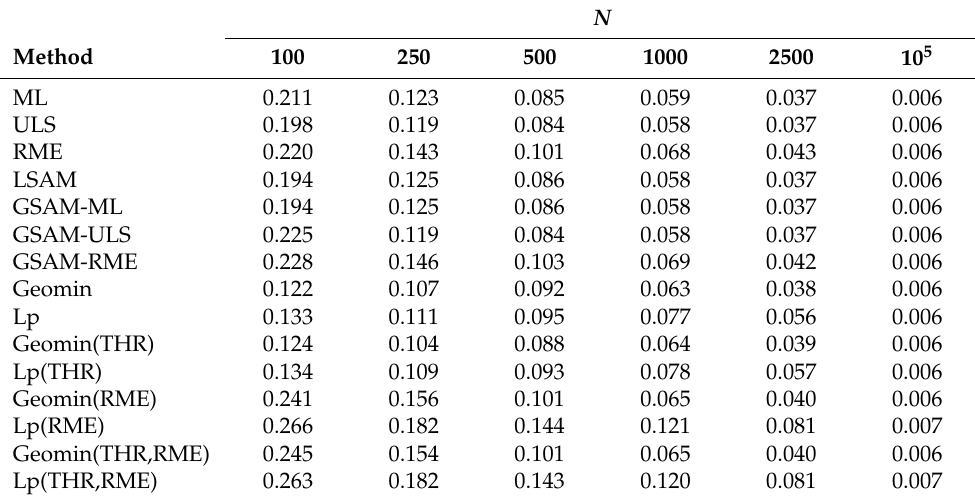
Lp(THR,RME) 0.263 0.182 0.143 0.120 0.081